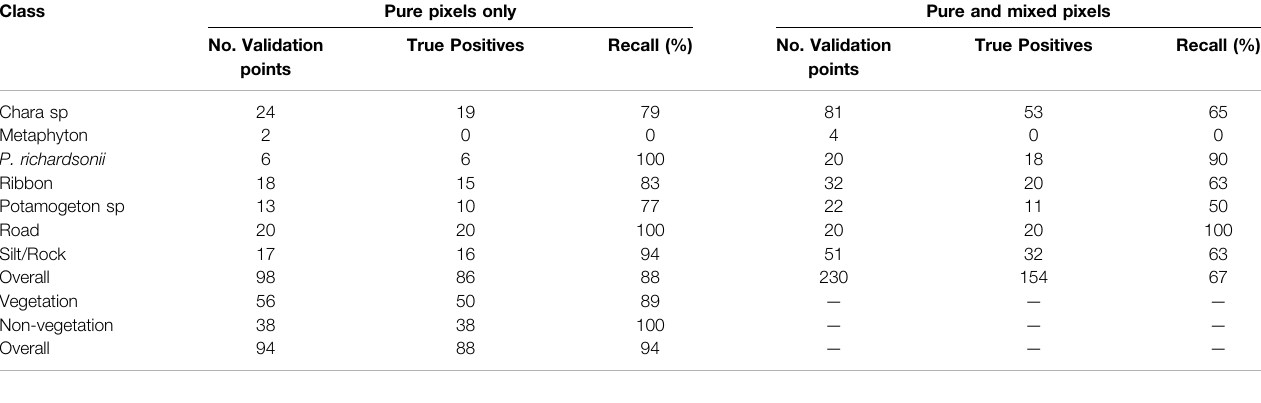
TABLE 4 | Validation results of the target detection analyses. Mixed pixels are identi fi ed as having at least 40% cover of the class in question.